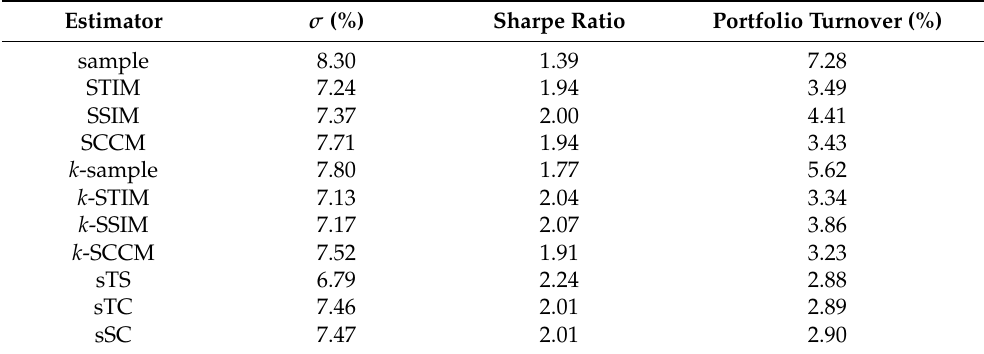
Table 2. Out-of-sample performance of eleven minimum variance portfolios with different covariance matrix estimations. All available stocks on the HOSE exchange are considered. Estimator